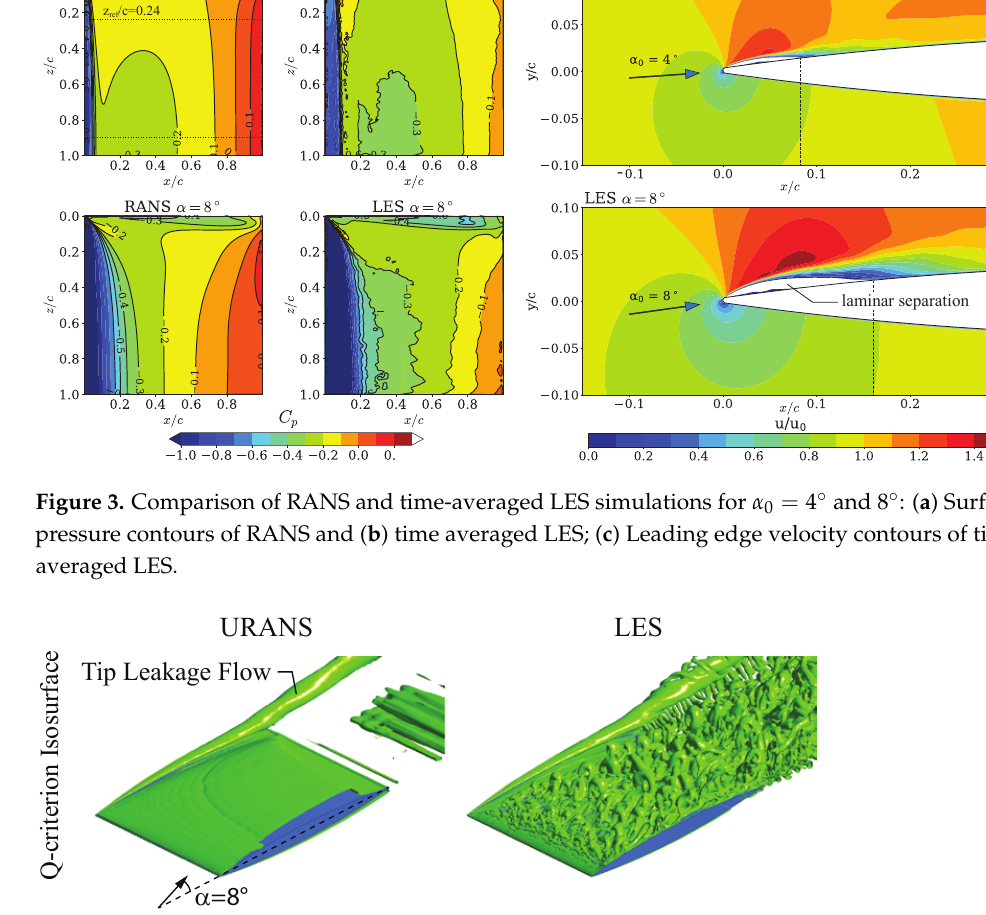
Figure 4. Comparison of instantaneous iso-surface of constant Q-criterion for URANS and LES simulation at α 0 = 8 ◦